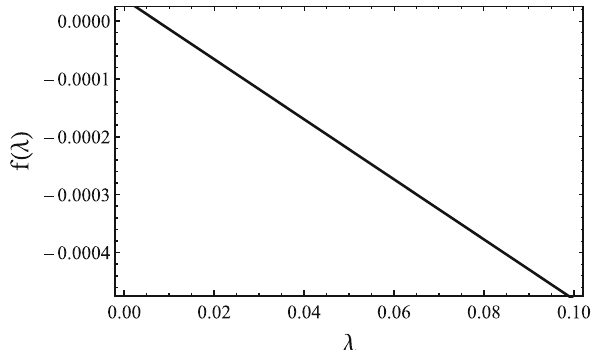
Fig. 1 f (λ) against λ for the given values of the test particle and black hole